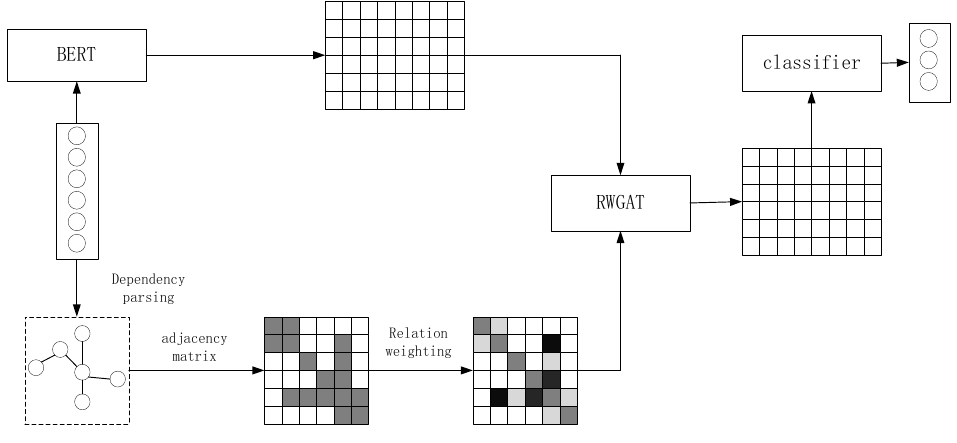
Figure 1. Model structural diagram.